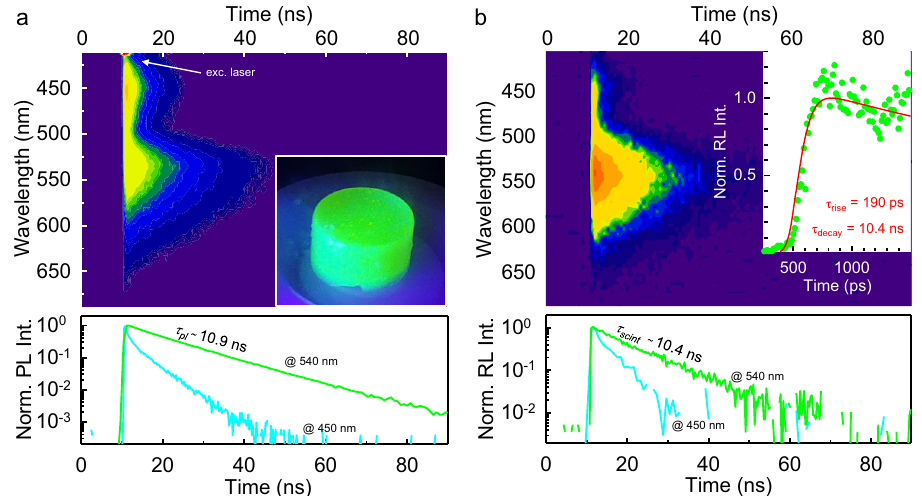
Fig. 5 Scintillation properties of large Stokes shift MOF-based nanocomposites. a 2D map of the time resolved photoluminescence (PL) of the composite under 405 pulse laser excitation. The inset is a digital picture of the composite under UV lamp exposure. The bottom panel shows the decays in time of the PL intensity recorded at 540 nm and 450 nm. b 2D map of the composite scintillation emission under pulsed X-rays exposure. The bottom panel highlight the decay in time of the scintillation pulse intensity recorded at 540 nm and 450 nm. The top panel inset shows the scintillation pulse recorded in the ultrafast time scale with the instrumental response function (IRF) and the fi t of the data with a pulse function convoluted with the IRF with a given average decay time τ decay of 10.4